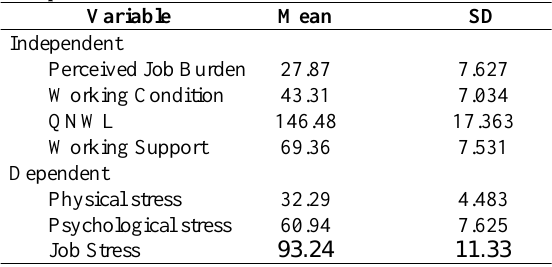
Table 2. Description of Independent and